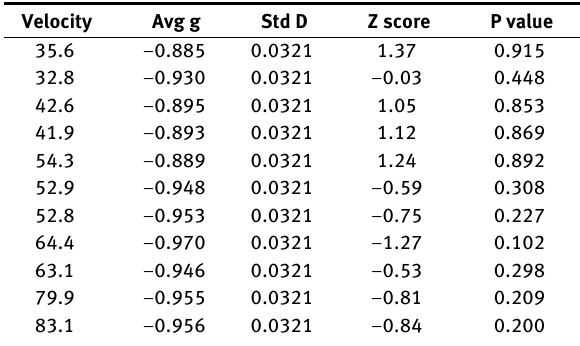
Table 3. Significance of variance in the average tyre/road friction coefficient in a vehicle fitted with antilock braking system.